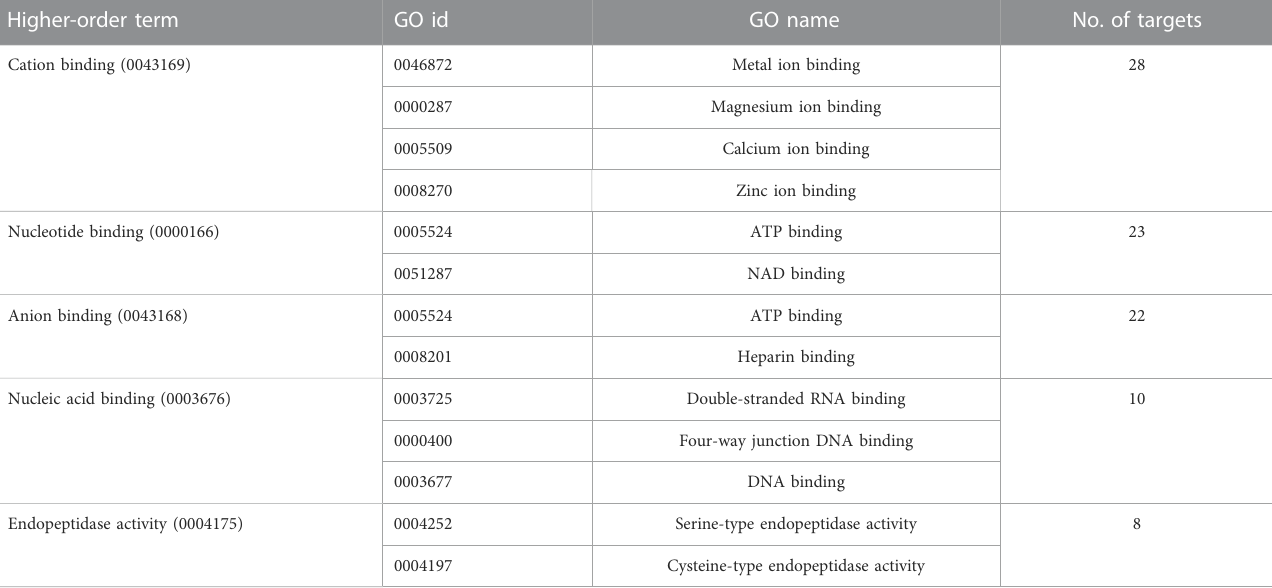
TABLE 3 The higher-order GO terms of the GO id ’ s of Table 2 and the numbers of suramin targets these higher-order GO terms are associated with. Higher-order